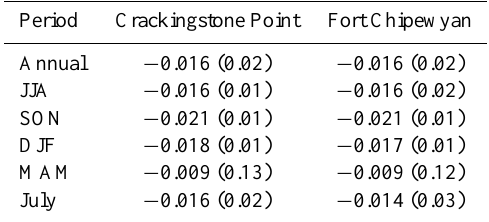
Table 1. Linear trends (myr − 1 ) of the naturalized lake levels at two locations on Lake Athabasca over 1960–2010 with p values given